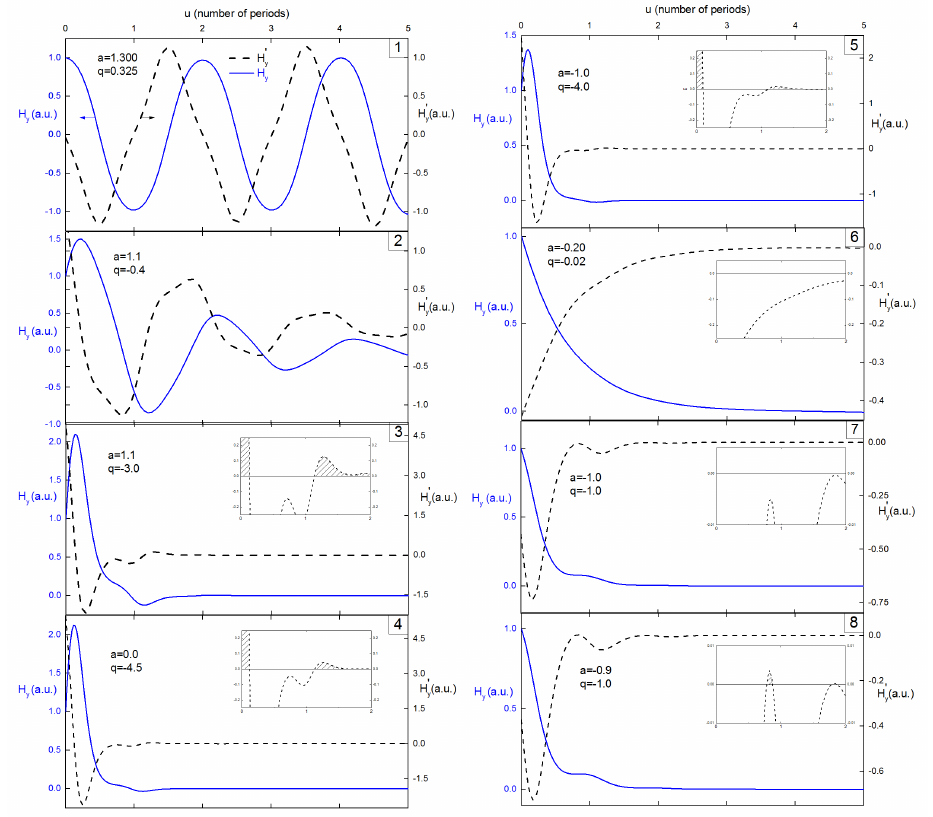
Figure 4. Solutions of the Mathieu’s equation plotted for different (a, q) -pairs depicted on Fig. 3. The solid blue line corresponds to the magnetic field H , the dashed black line – to its derivative H ′ . A photonic crystal with certain (a, q) - y y parameters can support surface waves if its solution is decreasing on the crystal scale and its derivative goes to zero to fulfill the continuity requirement. The inset images a zoomed region of the graph to show that the derivative does go to zero at certain points (graphs 1-4, 8) or never goes to zero (graphs 6,